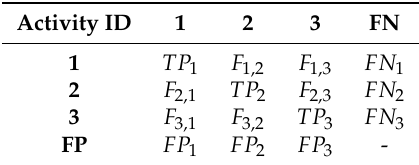
Table 3. Example of verification matrices of TP , FN and FP . TP represents the quantity of true positive; FN represents the quantity of false negative; and FP represents the quantity of false positive.